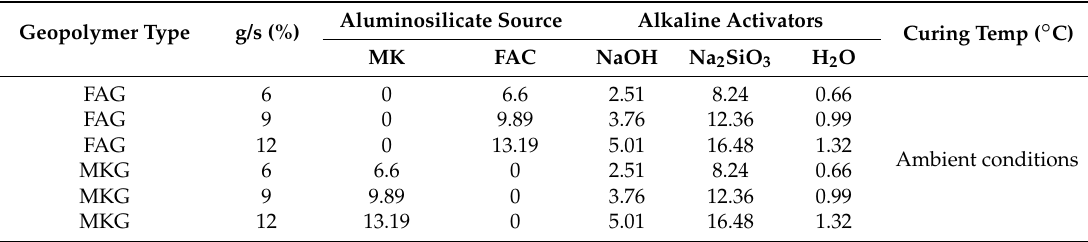
Table 2. Geopolymer mixtures based on 300 g of soil sample. All values are in grams unless indicated otherwise.